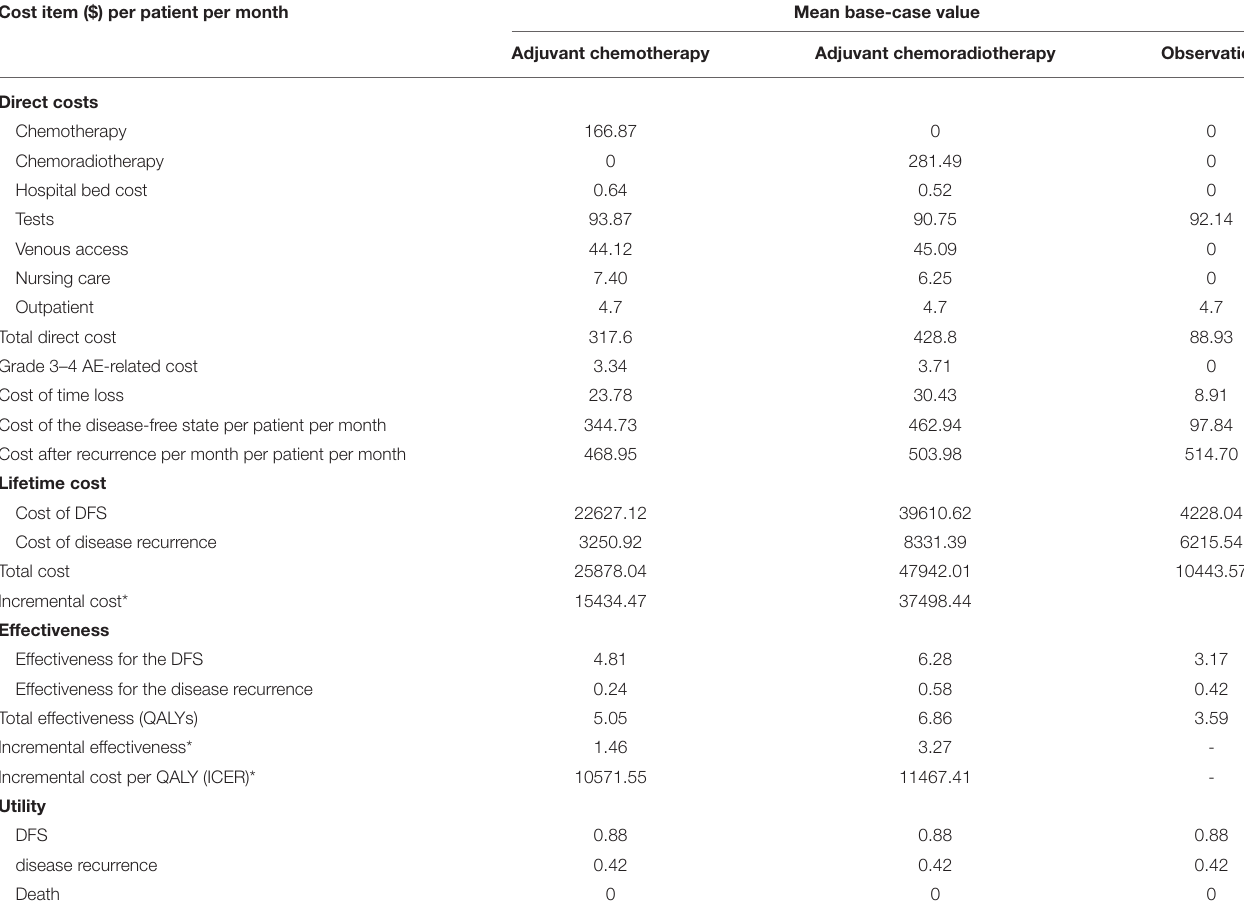
TABLE 5 | Cost, utility and base case analysis of the decision